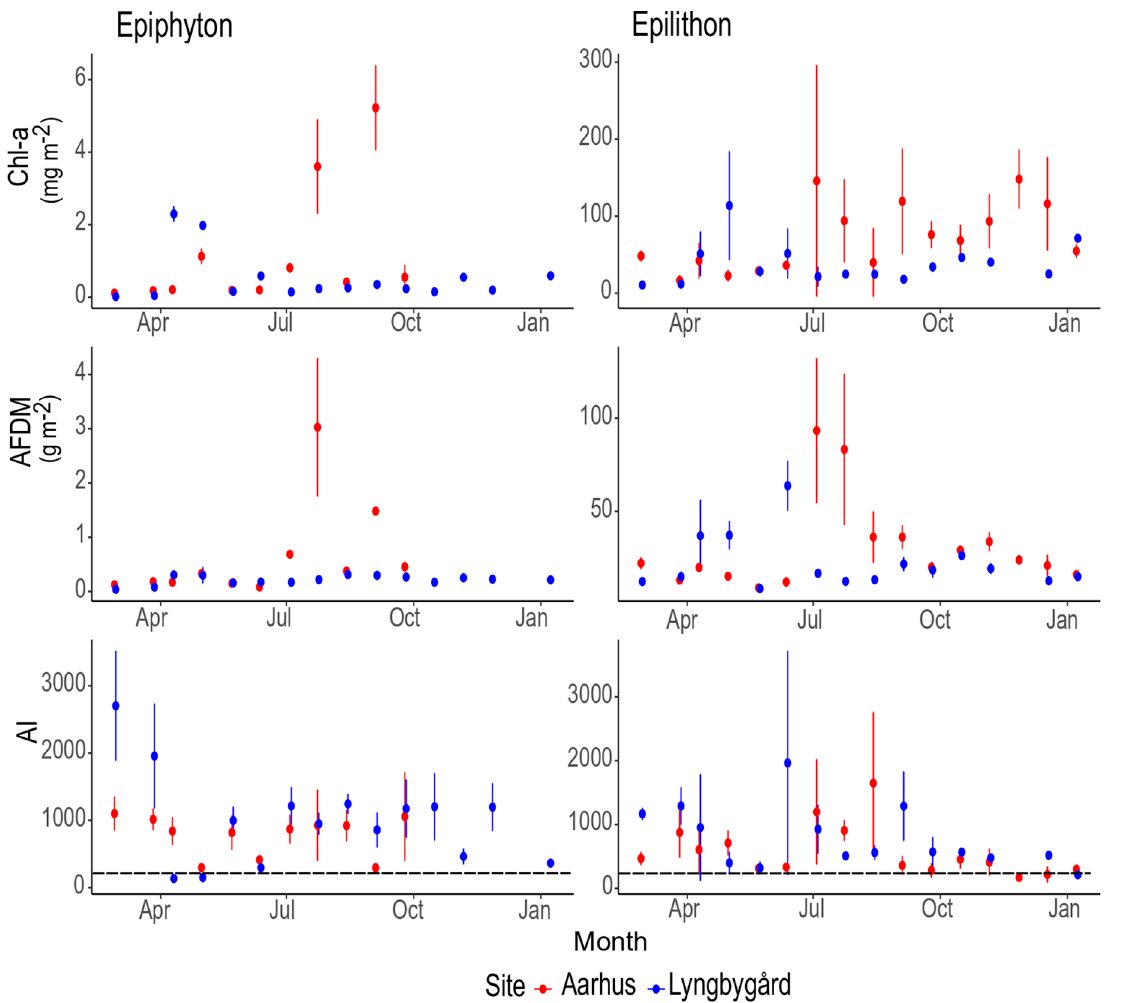
Figure 2. Changes in epiphytic and epilithic biomass and AI (per substrate area) throughout the annual study of the two streams. Dots and error bars denote mean and standard deviation values, respectively ( n = 3). The horizontal dashed lines in AI graphs show the index value of 200, which mark the limit between heterotrophic (above) or autotrophic (below) predominance in the biofilms.